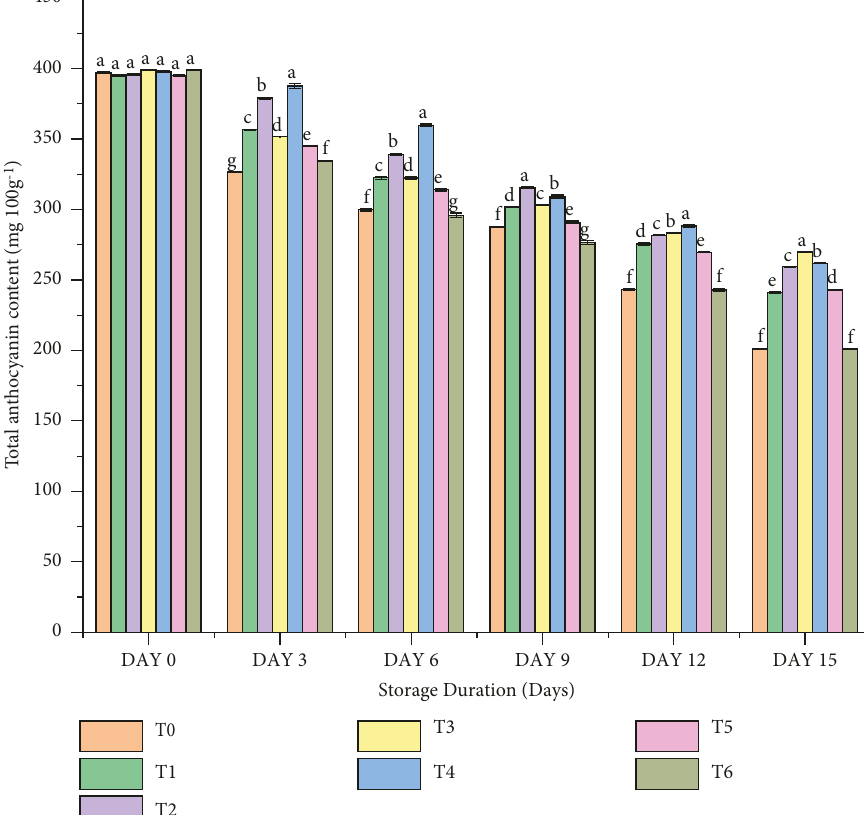
Figure 10: Effect of chitosan coating and cinnamon essential oil on total anthocyanin content (3d) of pomegranate arils during storage at 4 ± 1 ° C. Vertical bars represent the mean ± SD of 3 replicates. Error bars with different letters on the same storage period show a significant difference ( P ≤ 0 . 05). T0 � control; T1 � 1% chitosan+0.25% oil; T2 � 1% chitosan+0.5% oil; T3 � 2% chitosan+0.25% oil; T4 � 2% chitosan+0.5% oil; T5 � 3% chitosan+0.25% oil; T6 � 3% chitosan+0.5%